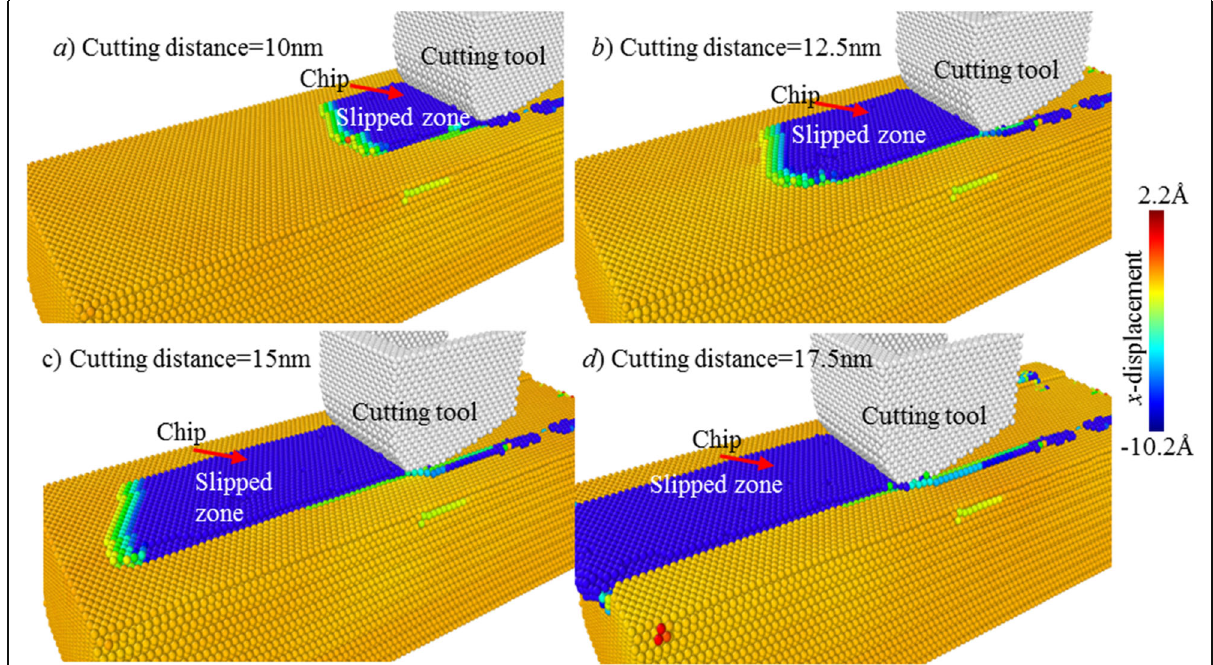
Fig. 11 Slip process of the targeted atomic layer at cutting edge radius of 2 nm. Atoms are coloured based on their x-direction atomic displacement values